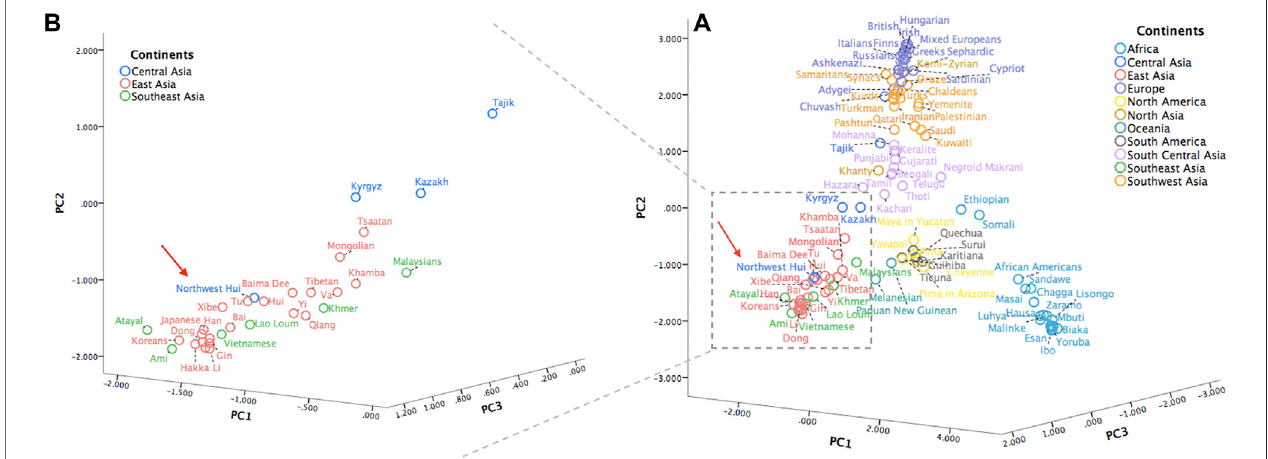
FIGURE11|(A) APCAplotoftheNorthwestHuigroupand109referencepopulationscarriedoutbasedonthefrequencydataof55AISNPs. (B) APCAplotofthe Northwest Hui group and populations from East, Southeast, and Central Asia. PCA, principal component analysis; AISNPs, ancestry-informative single-nucleotide